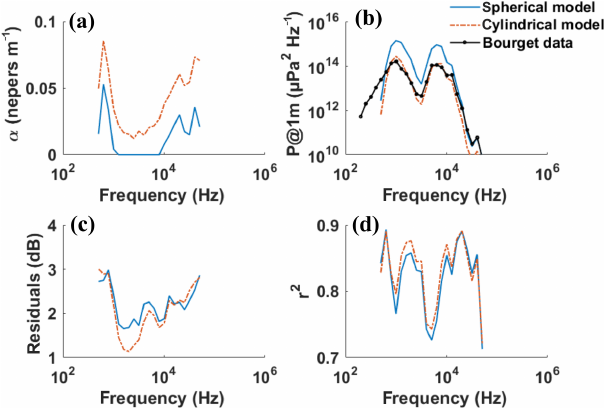
Figure 6. Data obtained for the Leysse River (a) attenuation coeffi- cient (nepersm − 1 ); (b) sound source power spectral density ( P @1m in µPa 2 Hz − 1 ) estimated with spherical/cylindrical models. Data from Lac du Bourget are the median values of the measurement presented in Fig. 2; (c) residuals of the regression (dB); (d) squared correlation coefficient of the fits.